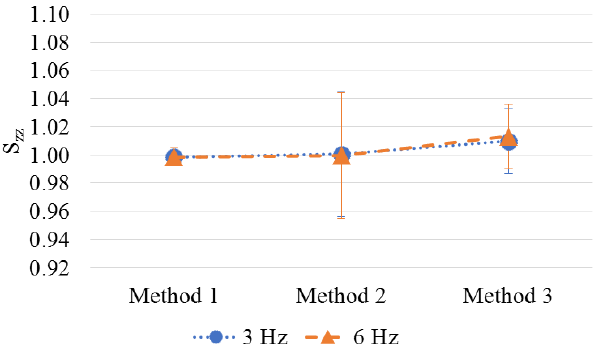
Figure 18. MEMS accelerometer: comparison between methods (main sensitivity along the x axis, S zz